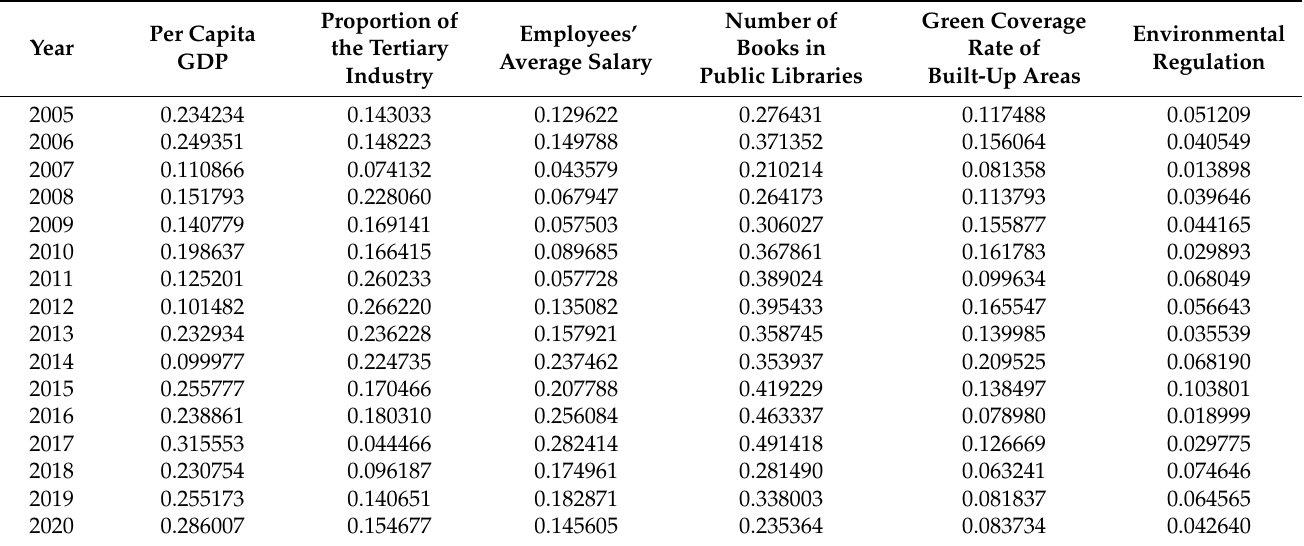
Table 3. The q values of the six indicators accounting for the impact on